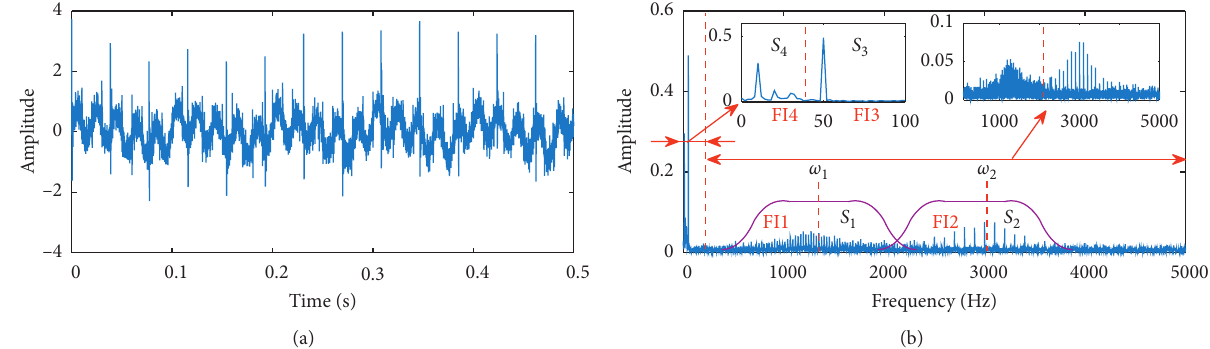
Figure 6: (a) The simulation signal s